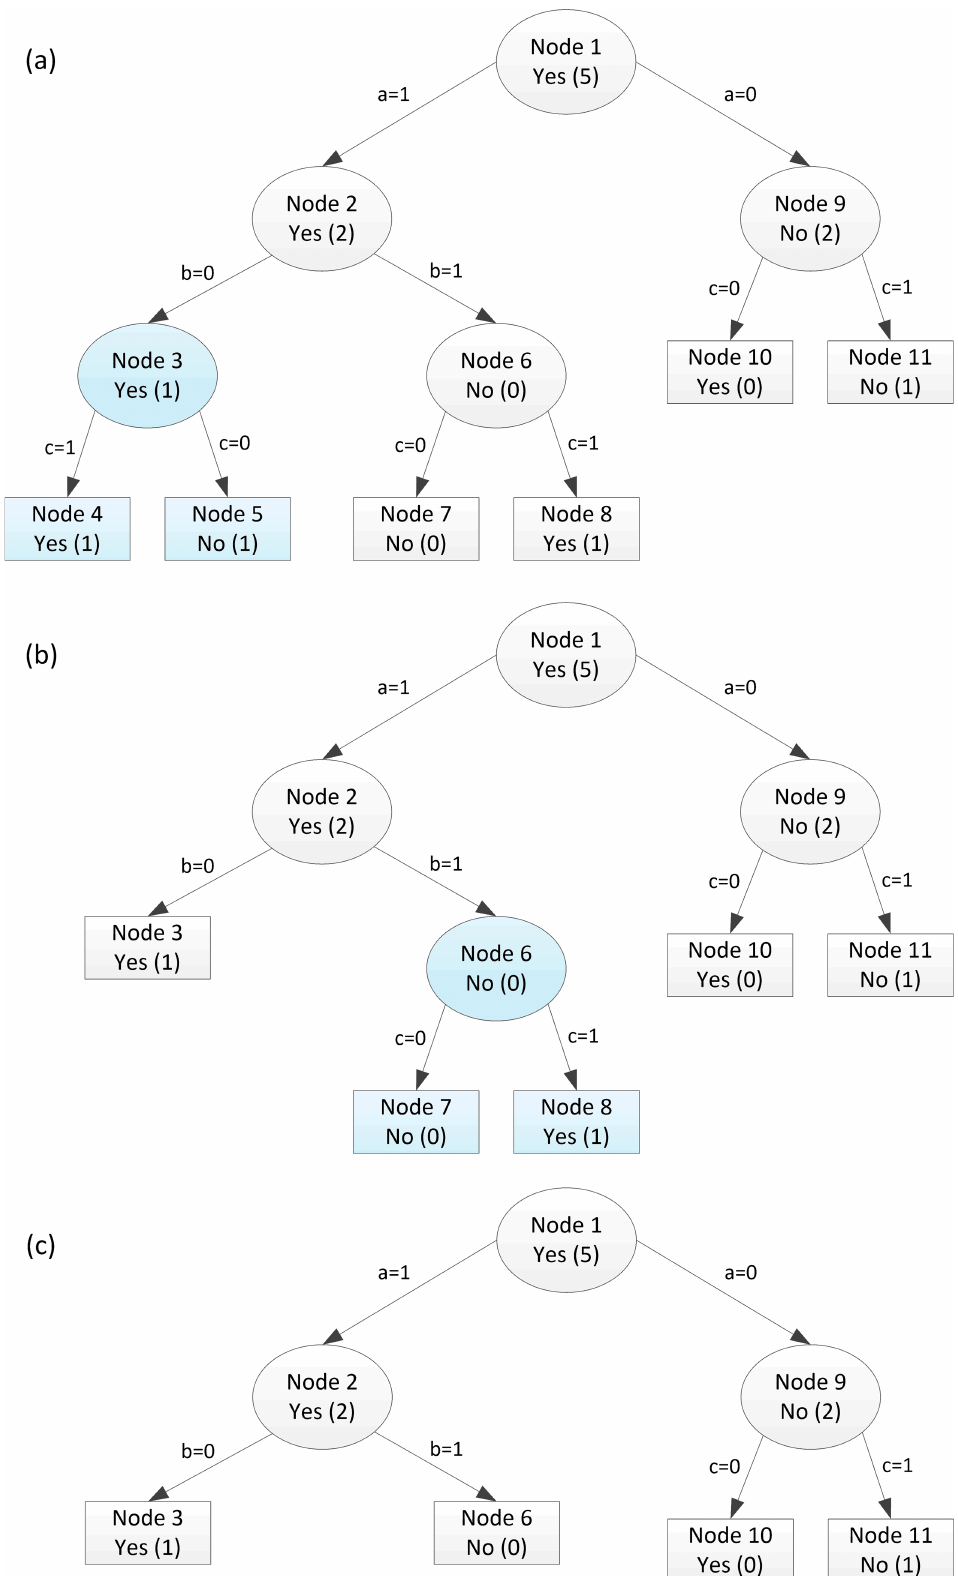
Fig 4. A simple decision tree example for PBMR